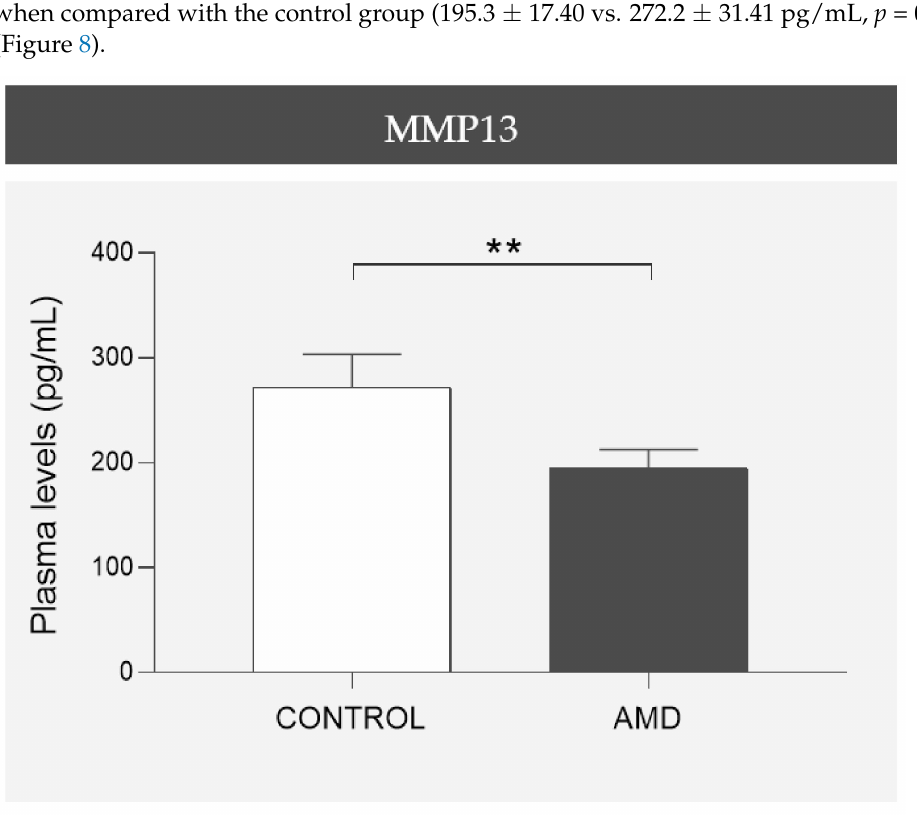
Figure 8. Comparison of mean total MMP13 plasma levels in the age- and sex-matched case–control cohort. A statistically significant difference was found in patients with wet AMD presenting lower plasma levels than controls. AMD = age-related macular degeneration, MMP13 = matrix metallopro- teinase 13. ** p < 0.01. Error bars correspond to the SEM. Control group, n = 52; AMD group, n = 52. Mann–Whitney U test was